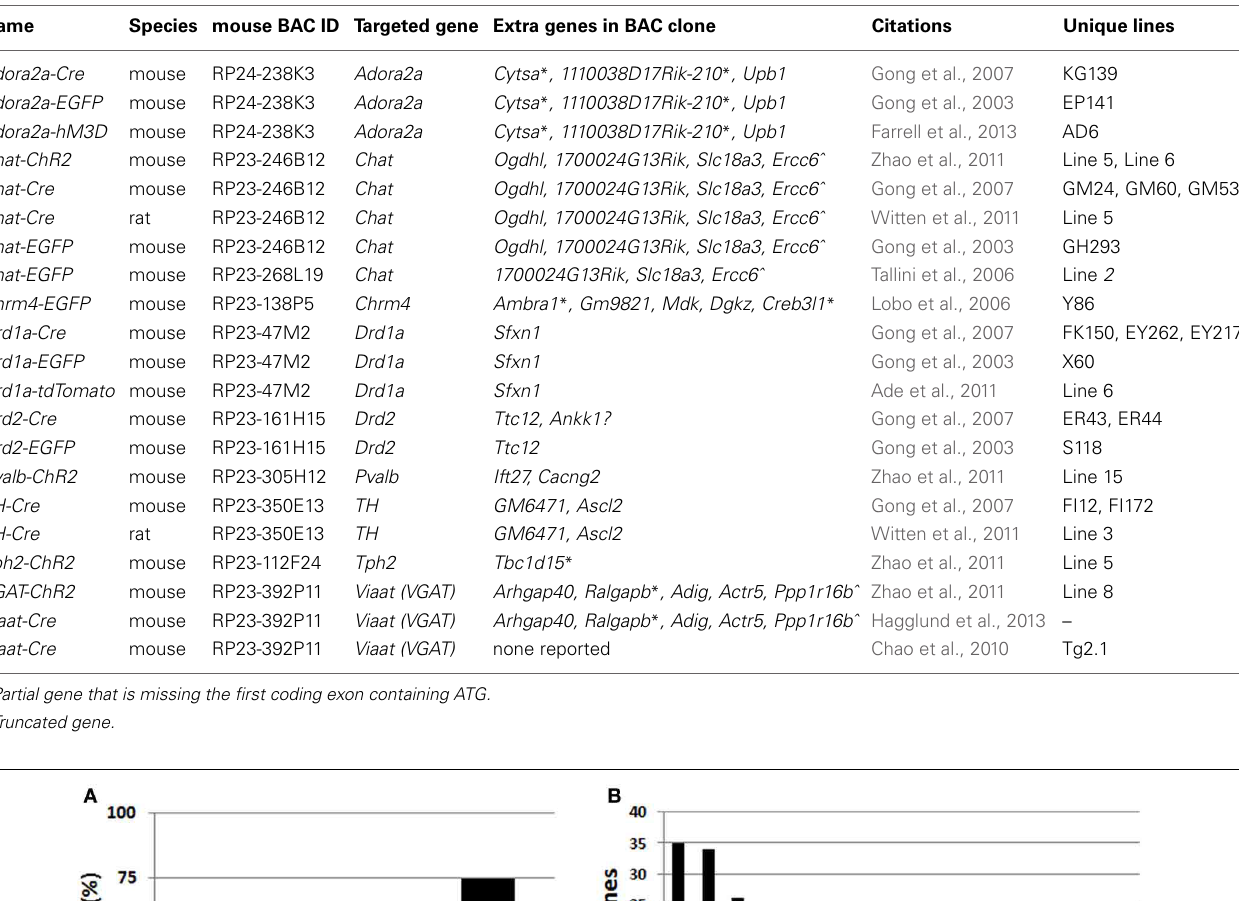
spanned. (B) Plot of the full distribution of extra gene number for the 139 BAC clones analyzed. Only intact genes that were fully contained within the BAC clone were